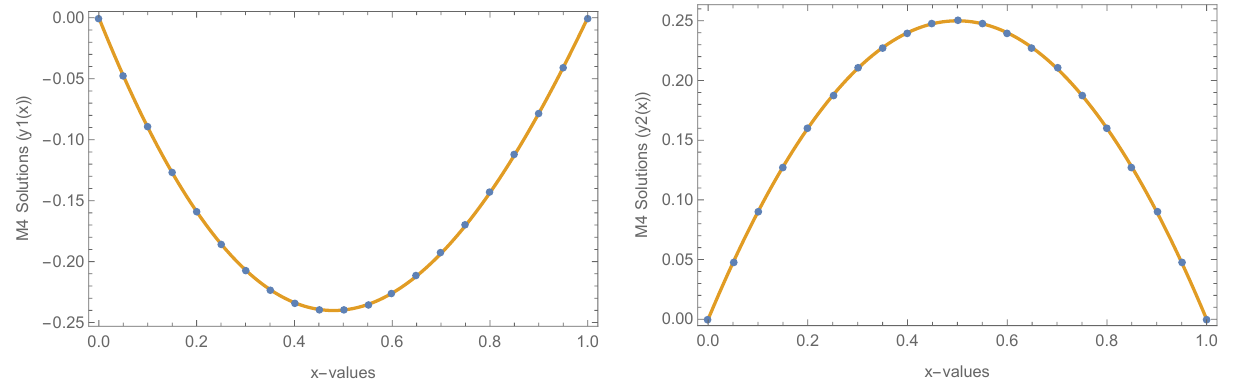
Figure 3. Exact and discrete solutions with the method TDHBM on Problem (25) with h = 1